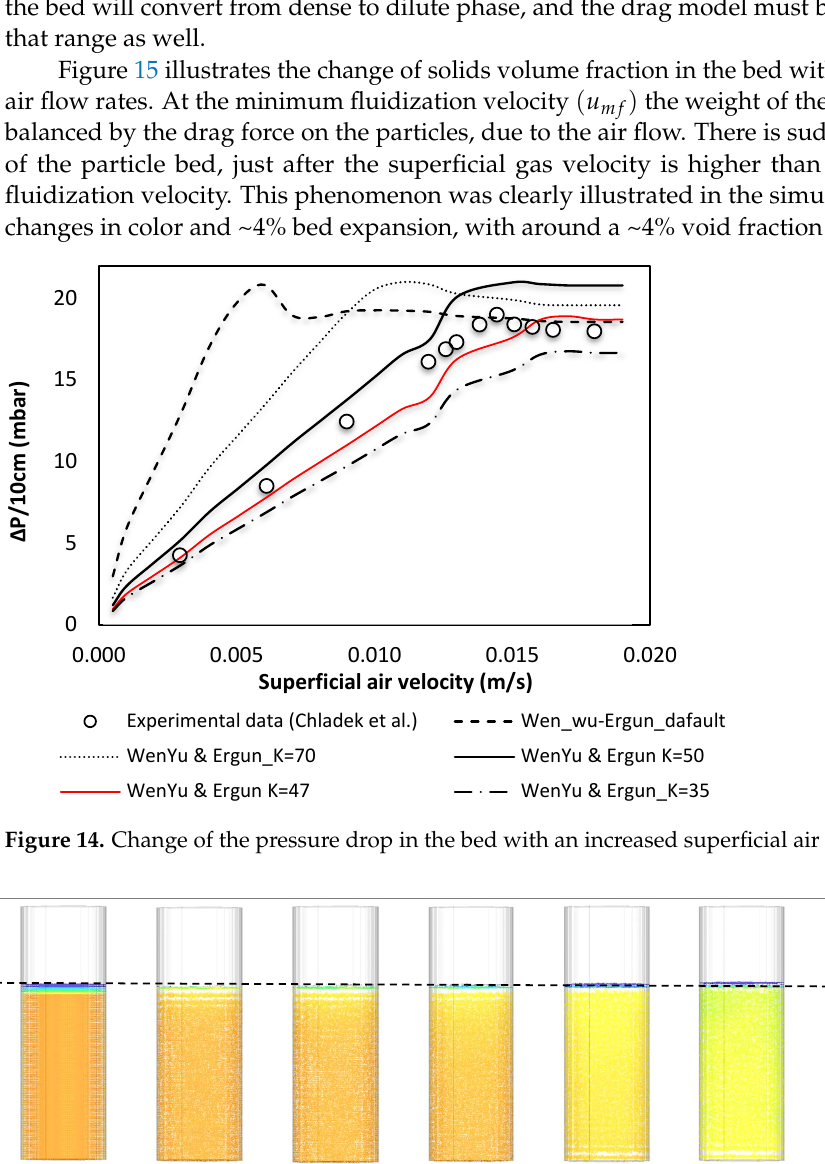
Figure 13. Snapshots for four different cases, both from experiments and from Barracuda simula ‐ tions applying the WenYu model for zirconia and the Ergun model for steel .